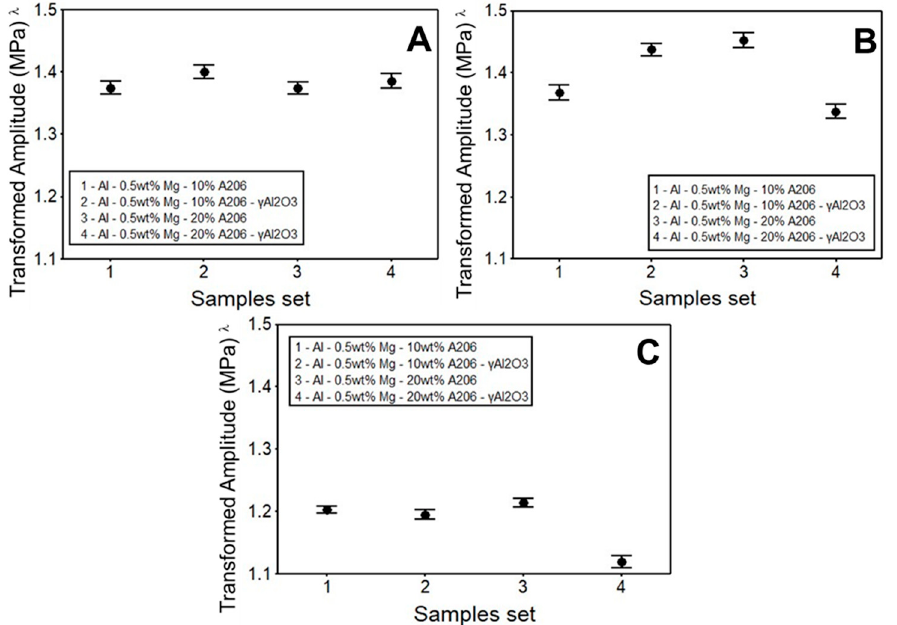
Figure 20. The transformed amplitude of the PLC phenomenon at different strain rate: ( A ) 0.125 mm/min strain rate, ( B ) 0.250 mm/min strain rate, and ( C ) 0.500 mm/min strain rate.